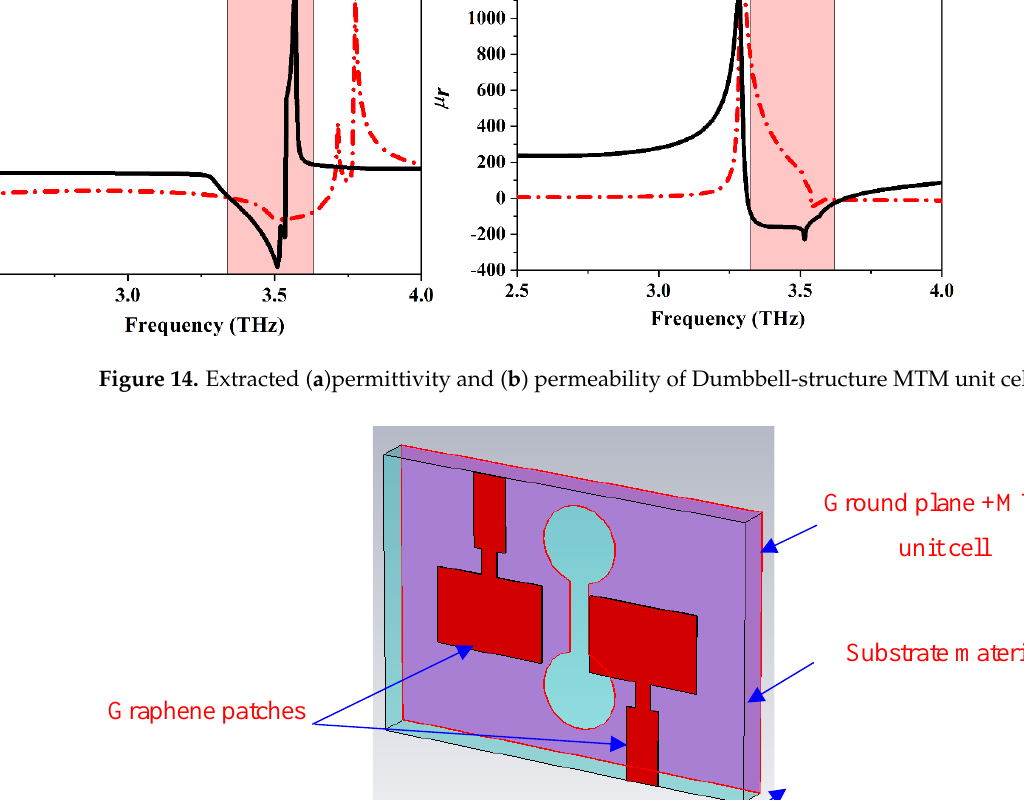
Figure 15. Ant. C structure in the presence of MTM unit cell.